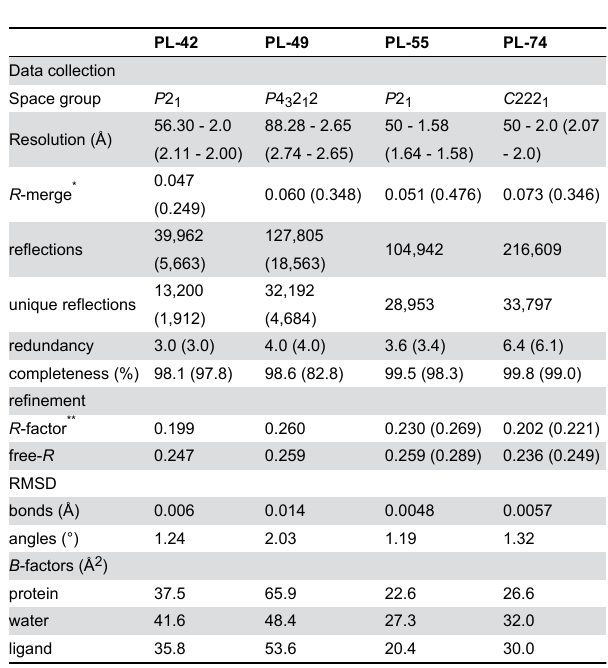
Table 1. Data collection and refinement statistics.